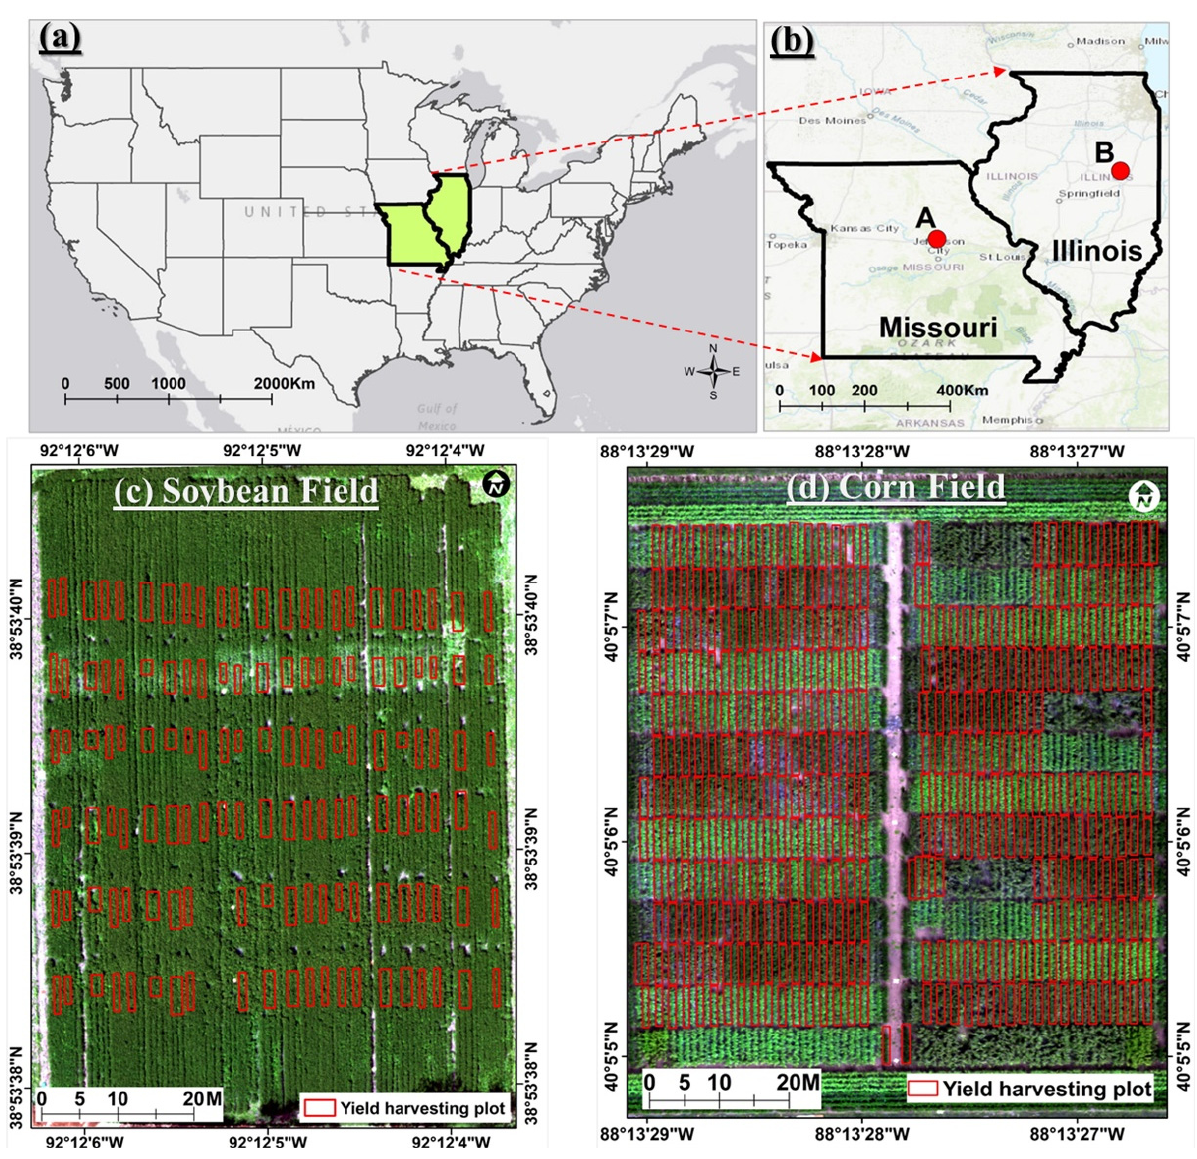
Figure 1. Study site location map and field layout. ( a ) Location of MO and IL, ( b ) experimental soybean field (the red dot A) in Missouri state and experimental corn filed (the red dot B) in Illinois state. ( c ) is UAV RGB orthomosaic of the experimental soybean field. ( d ) UAV RGB orthomosaic of the experimental corn field,(the red polygons are the yield harvesting spots)..